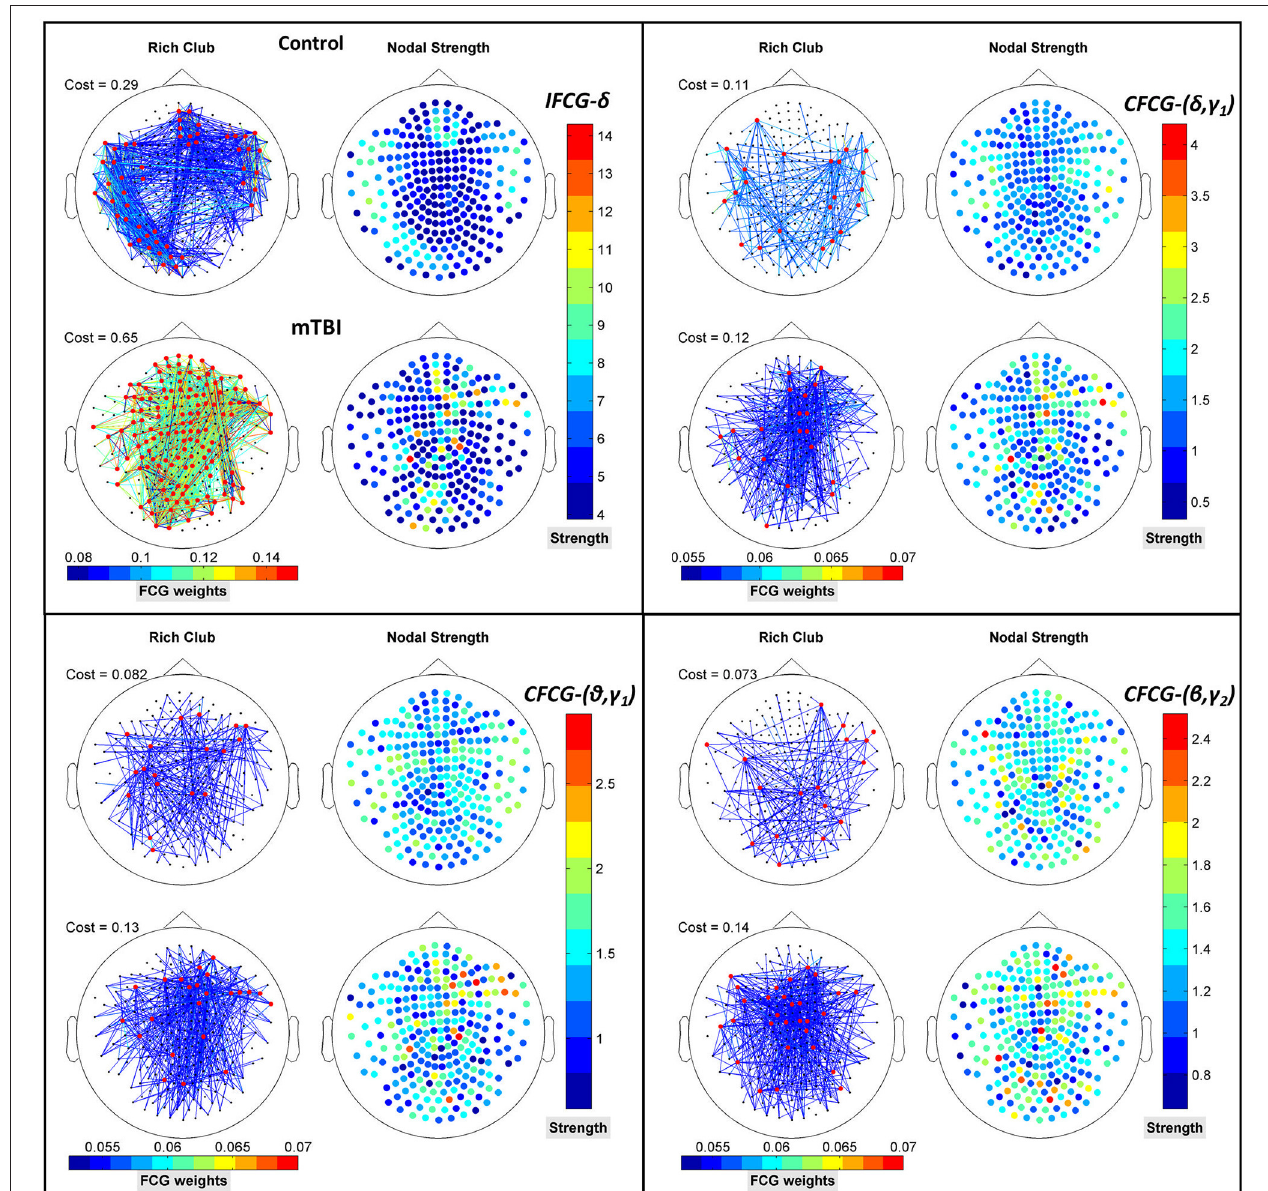
FIGURE 8 | Representation of the RC topology (red nodes on left topography for each sub-image) for each statistically significant case of Figure 7 with the nodal strength (colored right topography for each sub-image) of the corresponding FCG and edge cost. Each color bar is common to the control and mTBI